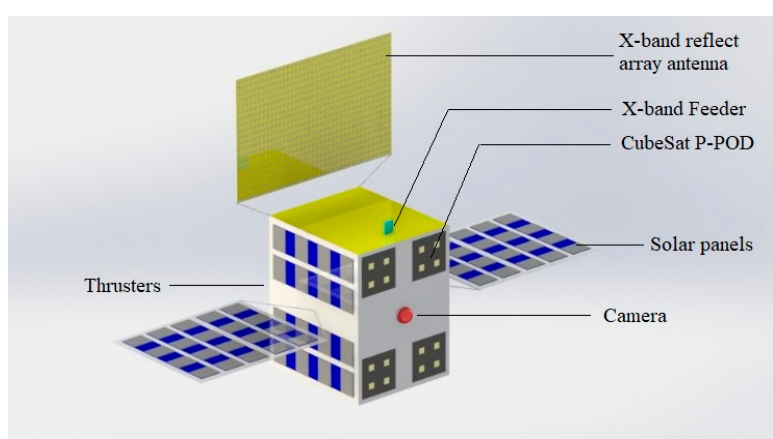
Figure 8. CubeSat characteristics.